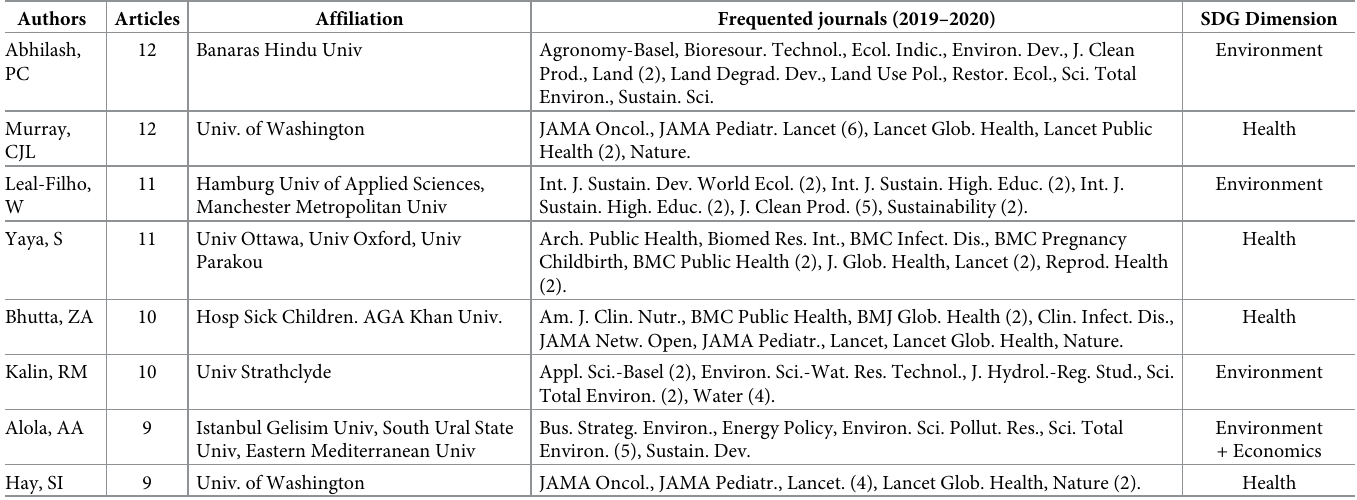
Table 2. Contemporary prolific authors,